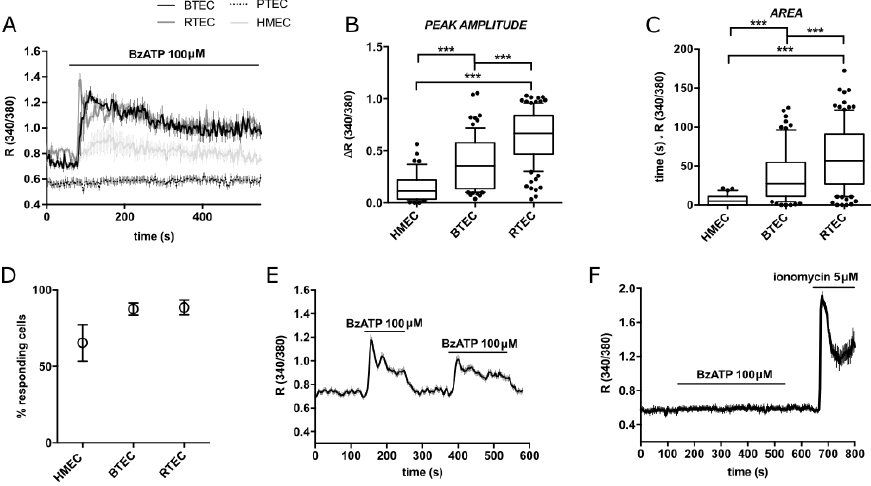
Figure 2. BzATP-triggered calcium signals in TEC and HMEC. ( A ) Representative traces of 100 µM BzATP-induced calcium signals in HMEC, BTEC, RTEC and PTEC. ( B , C ) Peak amplitude and area